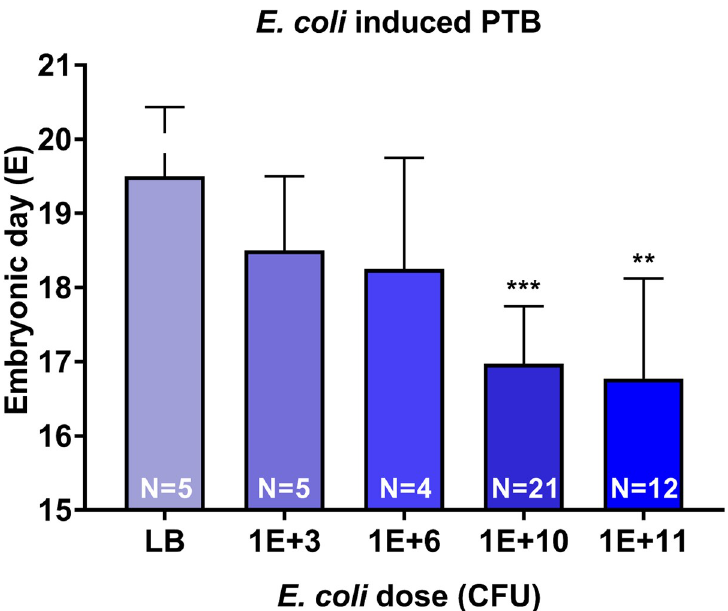
Fig 1. E . coli induced preterm birth (PTB) in dose dependent manner. Higher dose of E . coli (10 11 CFU and 10 10 CFU) significantly shortened gestational day of delivery compared to control (LB) ( P = 0.0012 and P < 0.001, respectively). Low dose of E . coli (10 6 CFU and 10 3 CFU) shortened gestational day of delivery compared to control, however it was not significant ( P = 0.17 and P = 0.2, respectively). CFU- colony forming